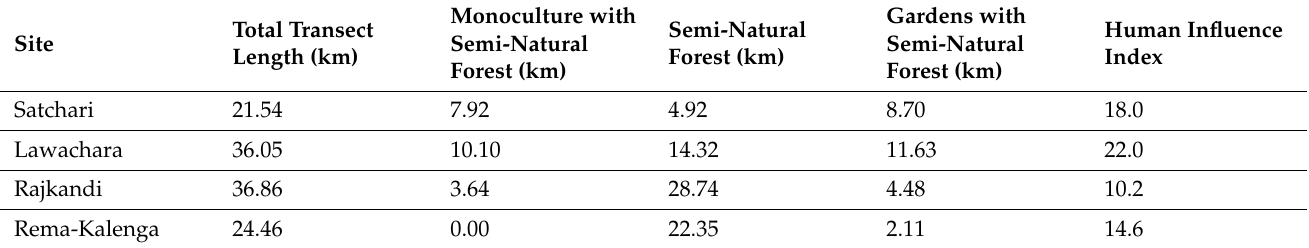
Table 1. Total length of transects, total representation of the three habitats, and mean Human Influence Index in the four